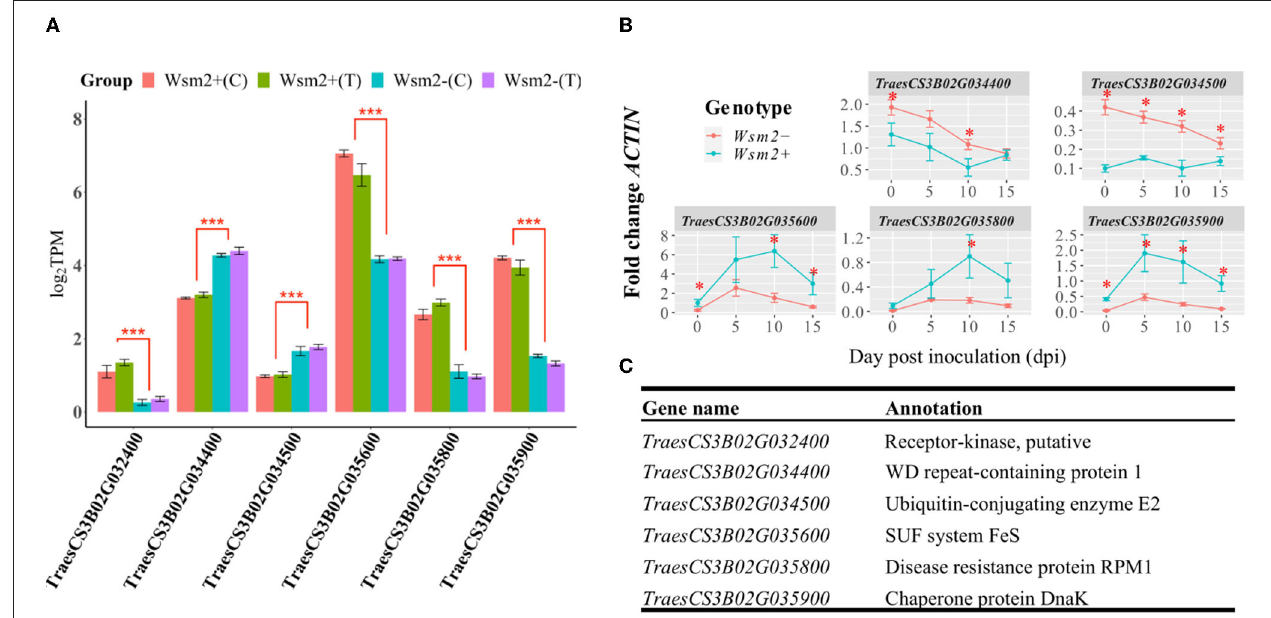
FIGURE 6 | Transcript levels of six DEGs within the Wsm2 region. (A) log 2 TPM values of six DEGs at 10 dpi quantified by RNA-seq. Values were color-coded by their sample group. Wsm2 + under WSMV-treated ( Wsm2 + T) and mock-treated condition ( Wsm2 + C); Wsm2 - under WSMV-treated ( Wsm2 - T) and mock-treated condition ( Wsm2- C). *** P < 0.001 (B) Relative expression in fold-change ACTIN levels for five of the DEGs at four time points (0, 5, 10, and 15-dpi), quantified by qRT-PCR. * P < 0.05. (C) Annotation for the six